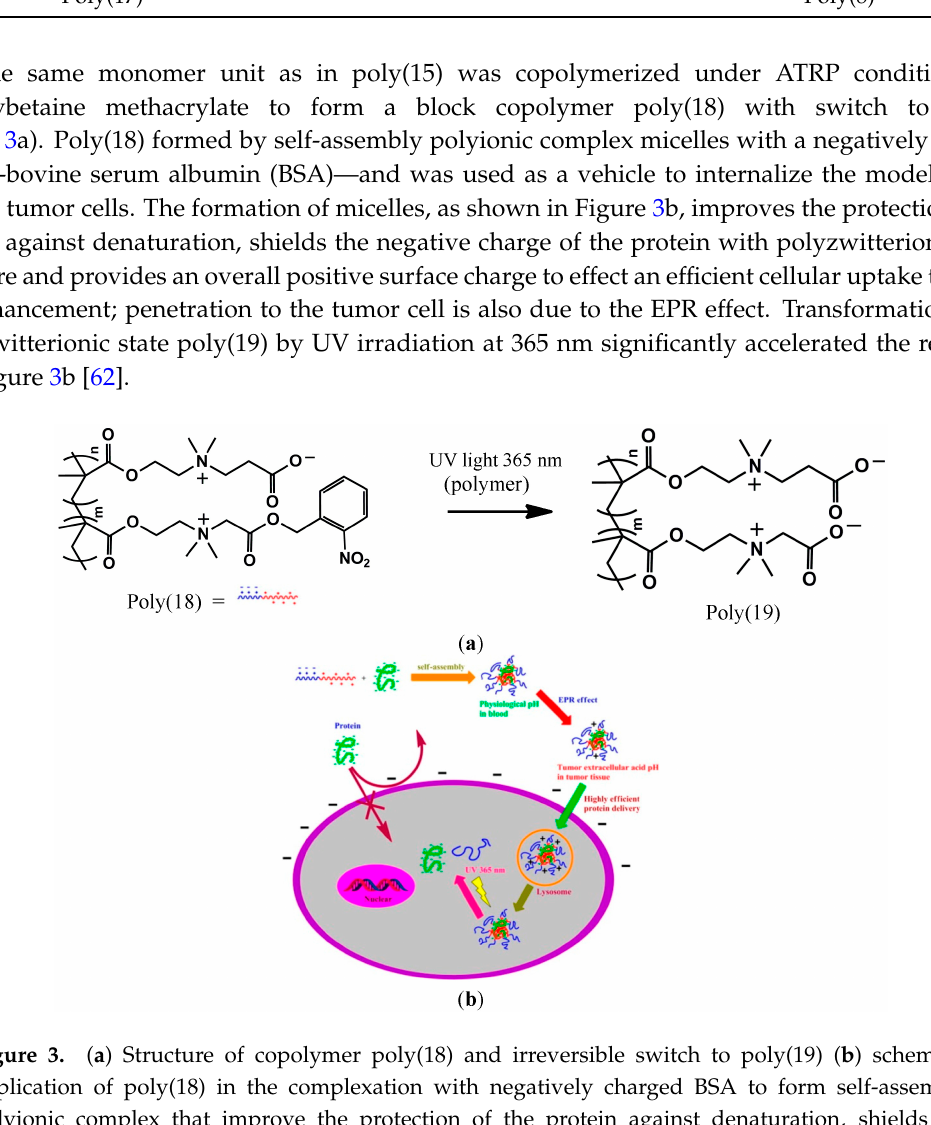
Table 1. Irreversible pH-triggered (meth)acrylic-based switches containing polyzwitterionic